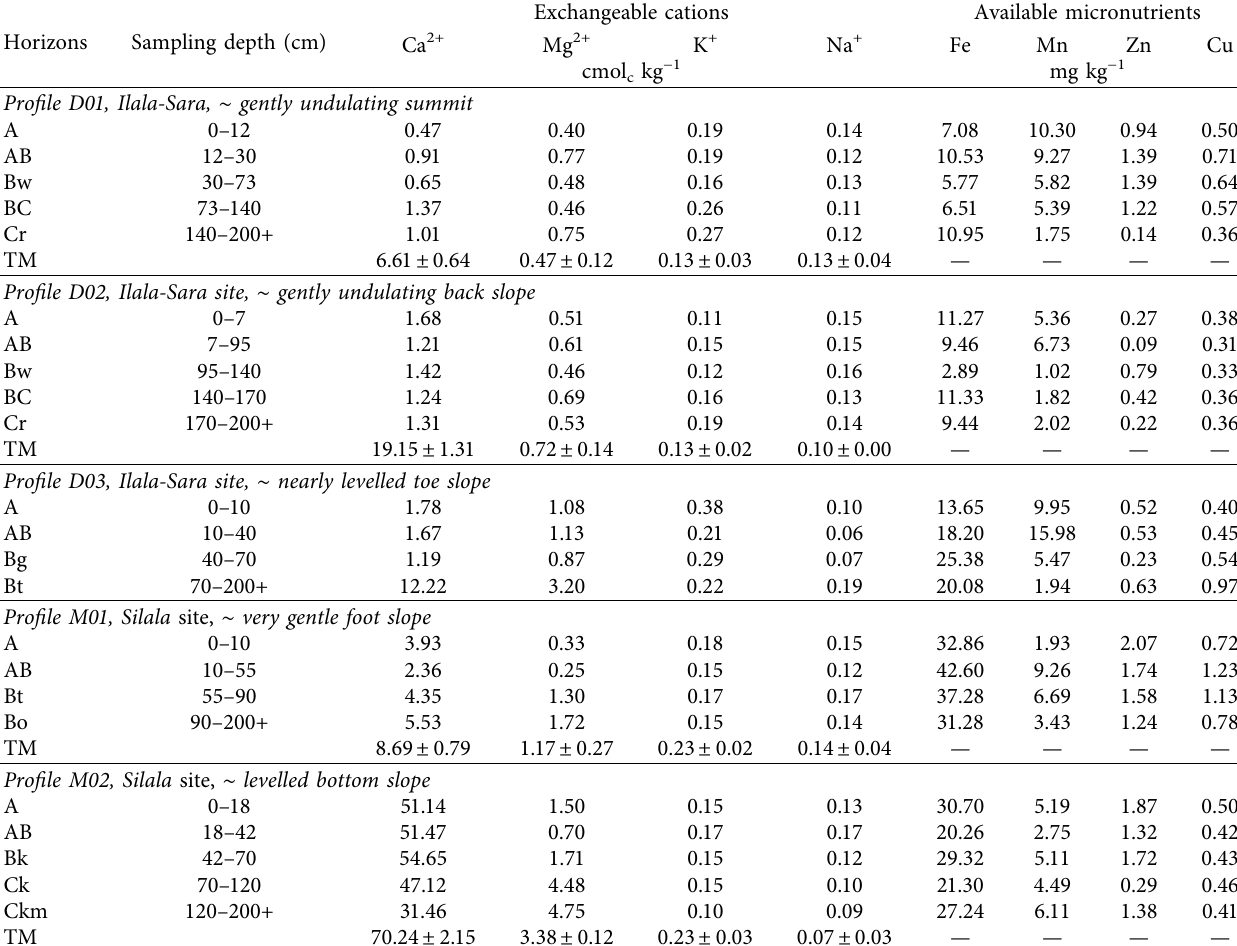
Exchangeable cations Available micronutrients